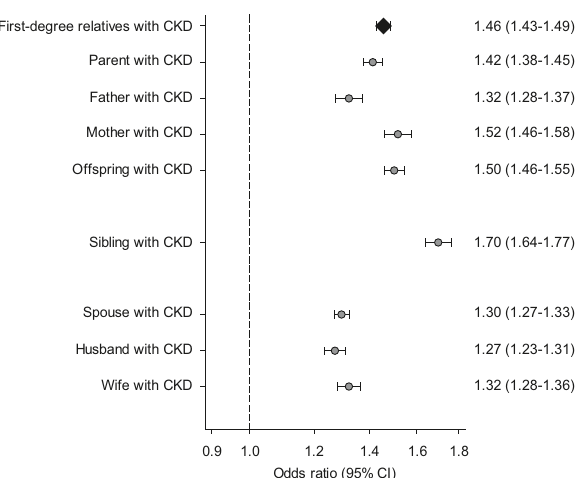
Figure 1. Risks of CKD in individuals having affected relatives with CKD. All models were adjusted for age, sex, residential area, income level, and comorbidities such as hypertension, diabetes, ischemic heart disease, cerebrovascular disease, and dyslipidemia. CKD, chronic kidney disease; CI, confidence